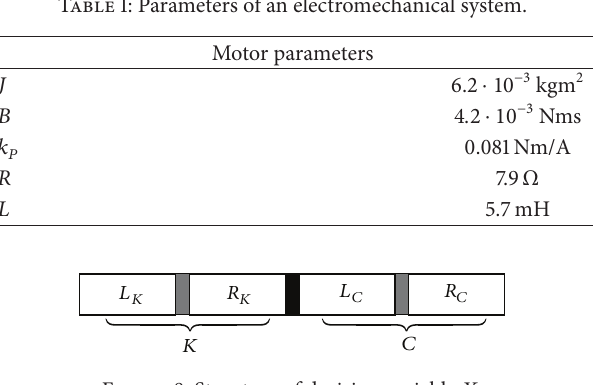
Figure 8: Structure of decision variable 𝑋